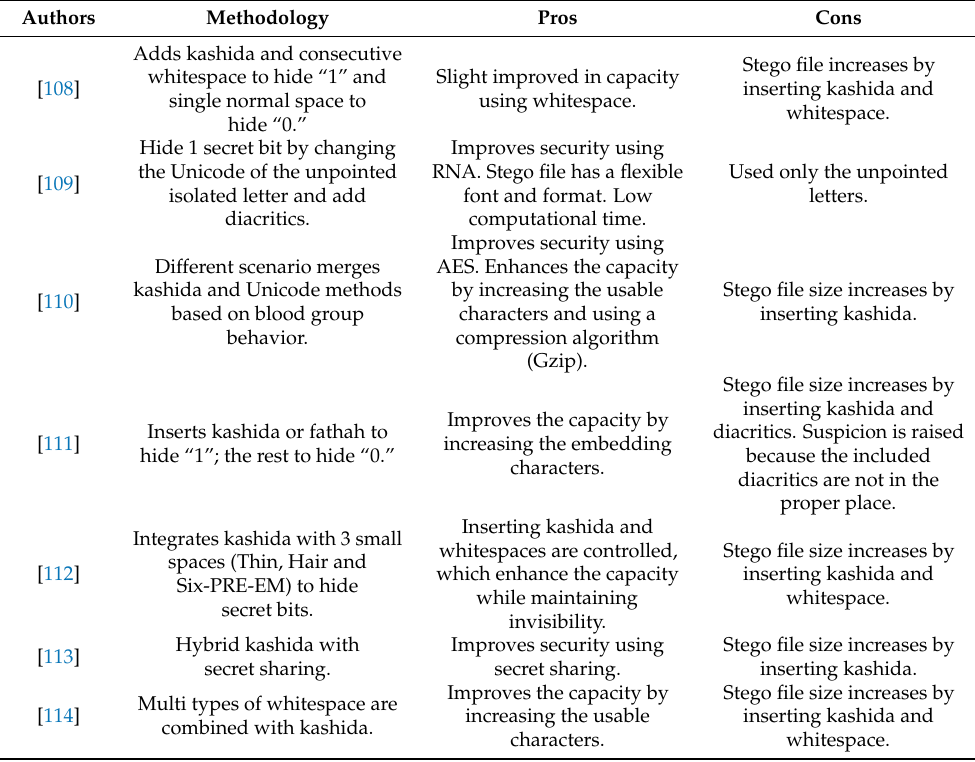
Table 19. A summary of the reviewed articles on the hybrid